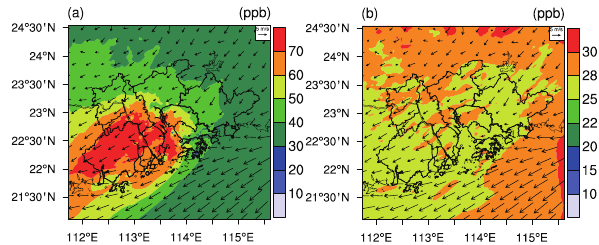
Fig. 5. Spatial distributions of surface ozone at 15:00LT in (a) con- trol run and (b) in background run.